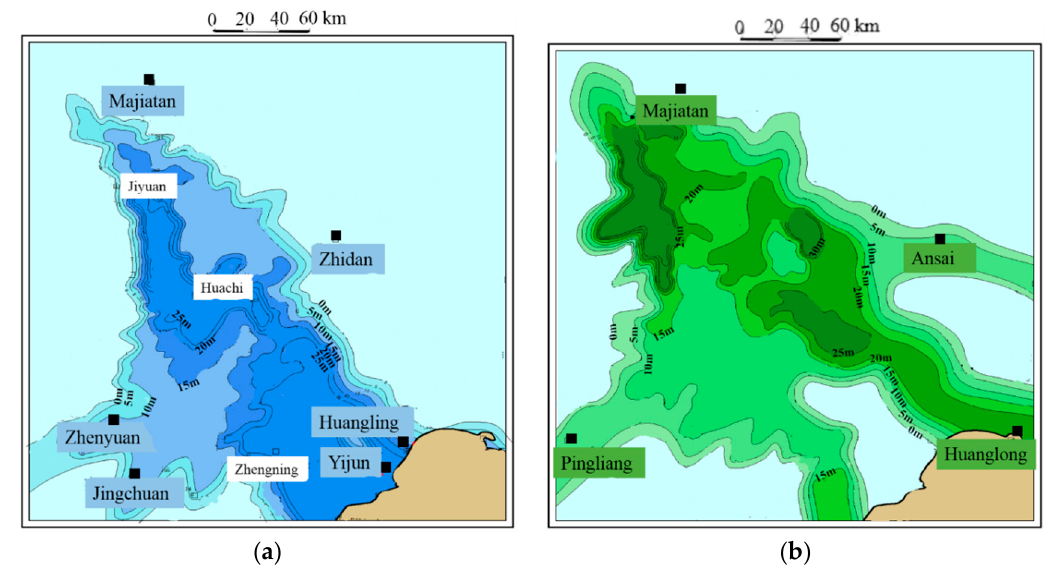
Figure 3. Isoline graph of the thickness of hydrocarbon source rock distributions in Chang 7, the Ordos Basin: ( a ) Oil shale, ( b ) dark mudstone.